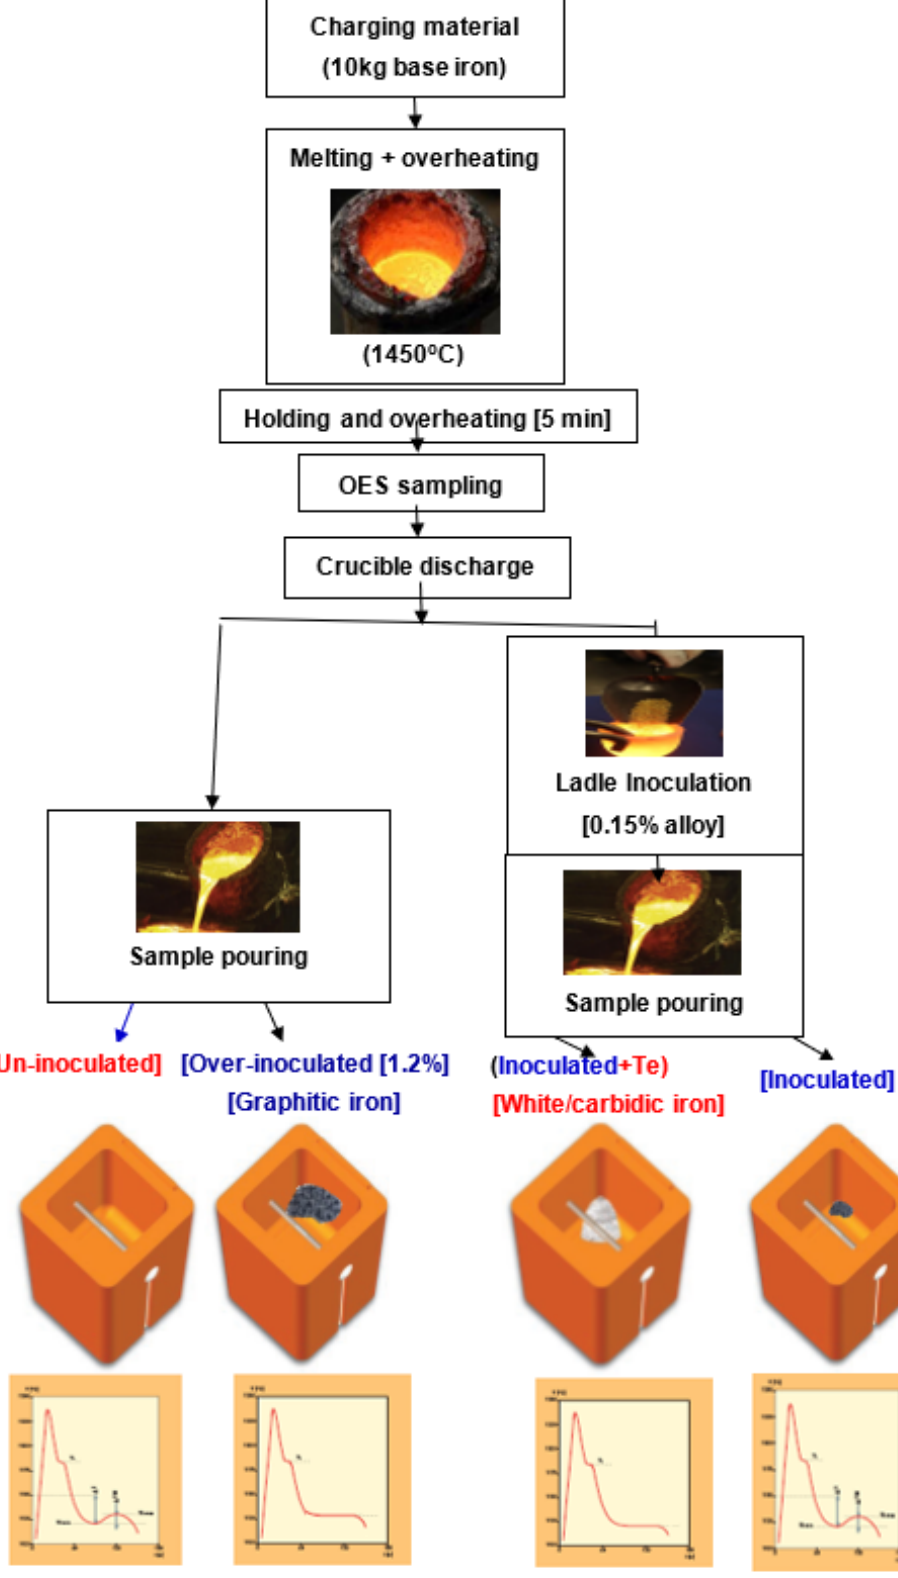
Figure 2. Experimental schedule for thermal (cooling curve)